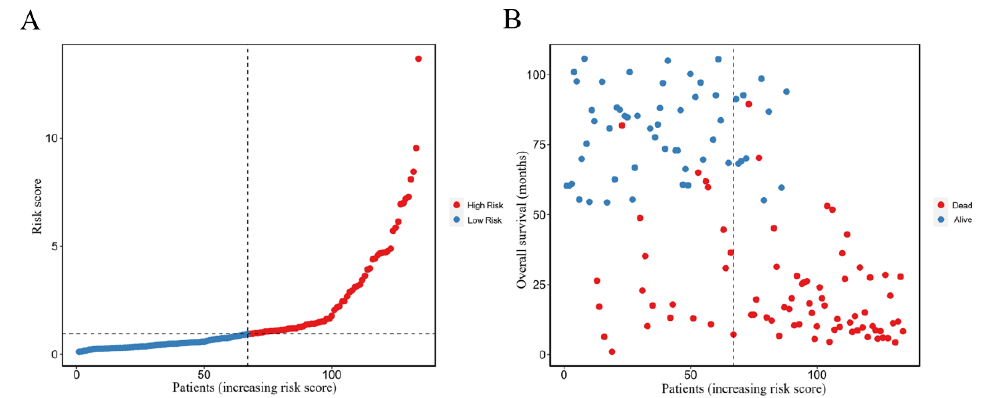
Figure 6. The association between risk score, OS and survival status in the predictive nomogram is shown in scatter plot. ( A ) Risk score ranking of patients. ( B ) Distribution of risk score and associated overall survival.